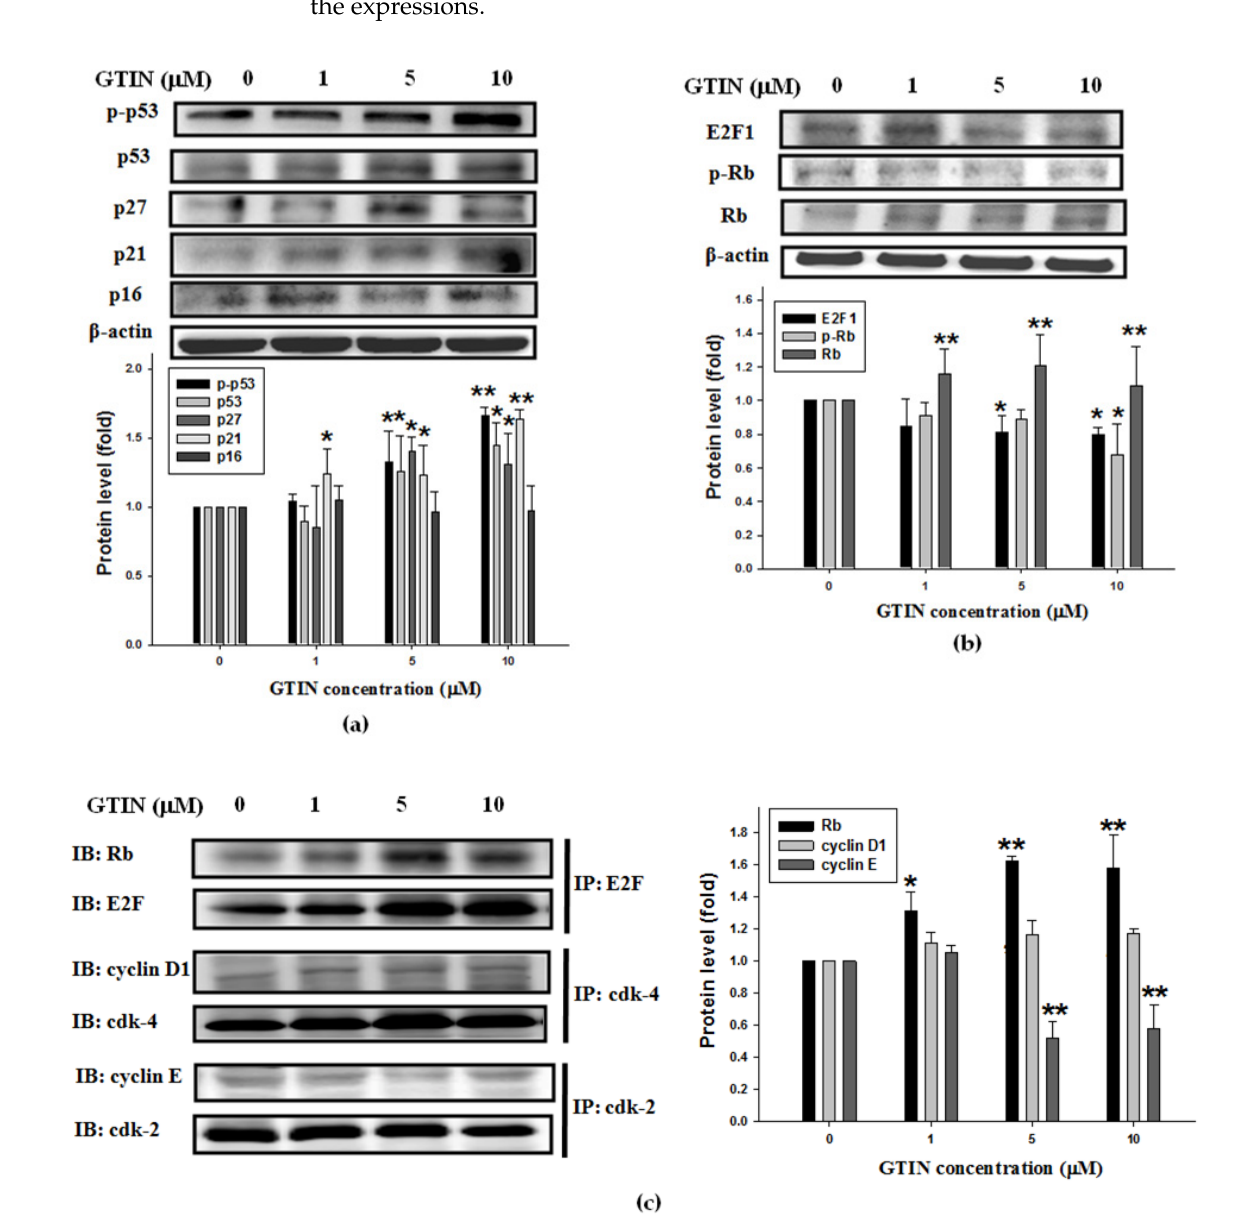
Figure 2. GTIN modulated cell-cycle regulatory factors in VSMCs. A7r5 cells were incubated with GTIN at the indicated doses (0, 1, 5 and 10 µ M) for 48 h. The protein levels of p-p53, p53 and CDKIs, including p27, p21 and p16 ( a ), E2F1, Rb, p-Rb ( b ) and β -actin, as an internal control, were assayed by WB. ( c ) The expressions of Rb/E2F1, cyclin D1/cdk-4 and cyclin E/cdk-2 complexes were determined. The protein lysate was immunoprecipitated (IP) with anti-E2F1, cdk-4 or cdk-2 antibodies. The precipitated complexes were then analyzed for immunoblotting (IB) applying antibodies against Rb, cyclin D1 or cyclin E. All quantitative results were showed as mean ± SD of three repeats from at least three independent experiments. * p < 0.05, ** p < 0.01 compared with the untreated control via one-way ANOVA with Dunnett’s post-hoc analysis.